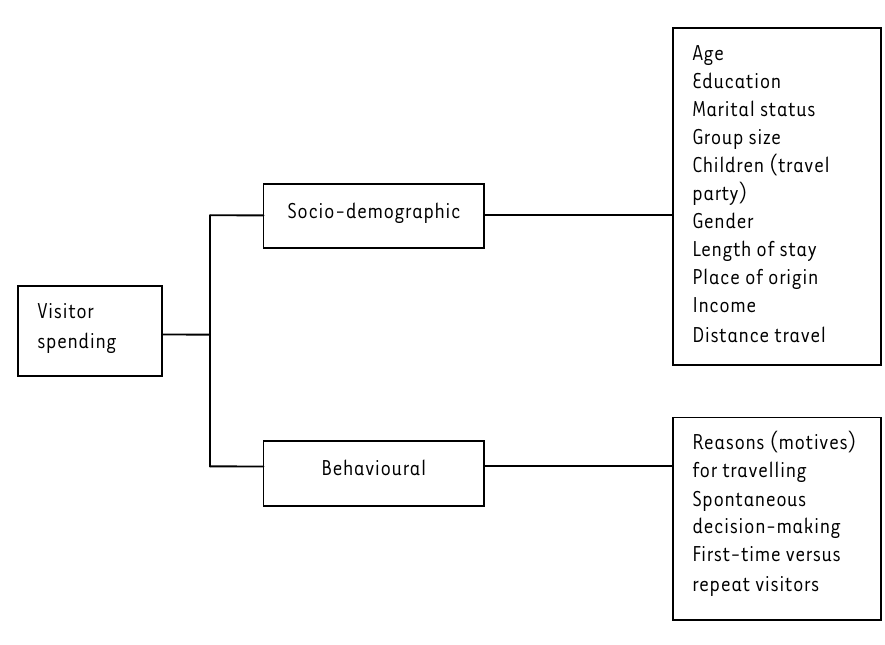
FIGURE 1: Key determinants in festivals Source: Compiled by